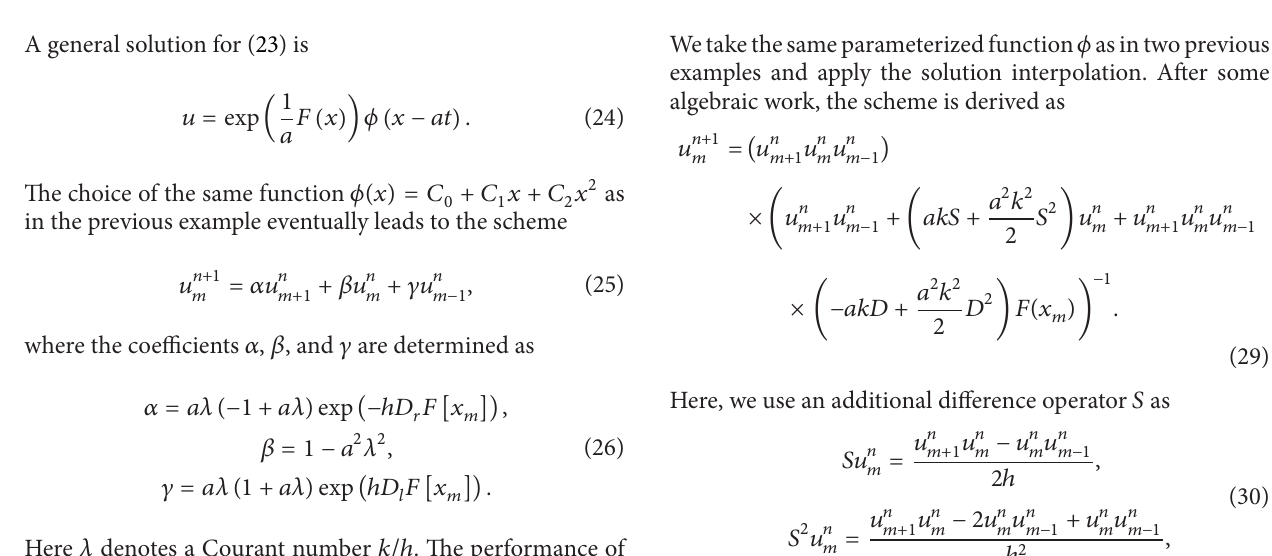
Figure 2: Numerical solutions for 𝑢 𝑡 + 𝑎𝑢 𝑥 = sin (𝑥/𝜀) : a solution 𝑢 = (𝑥−𝑡)( sin (𝑥−𝑡)+2) −1 −𝜀 cos (𝑥/𝜀) is used to generate initial/boundary conditions and measure